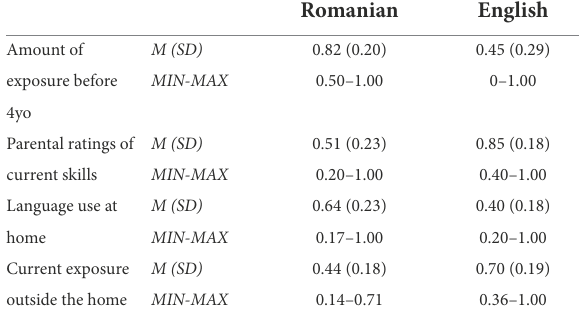
TABLE 1 Language background information for the heritage Romanian